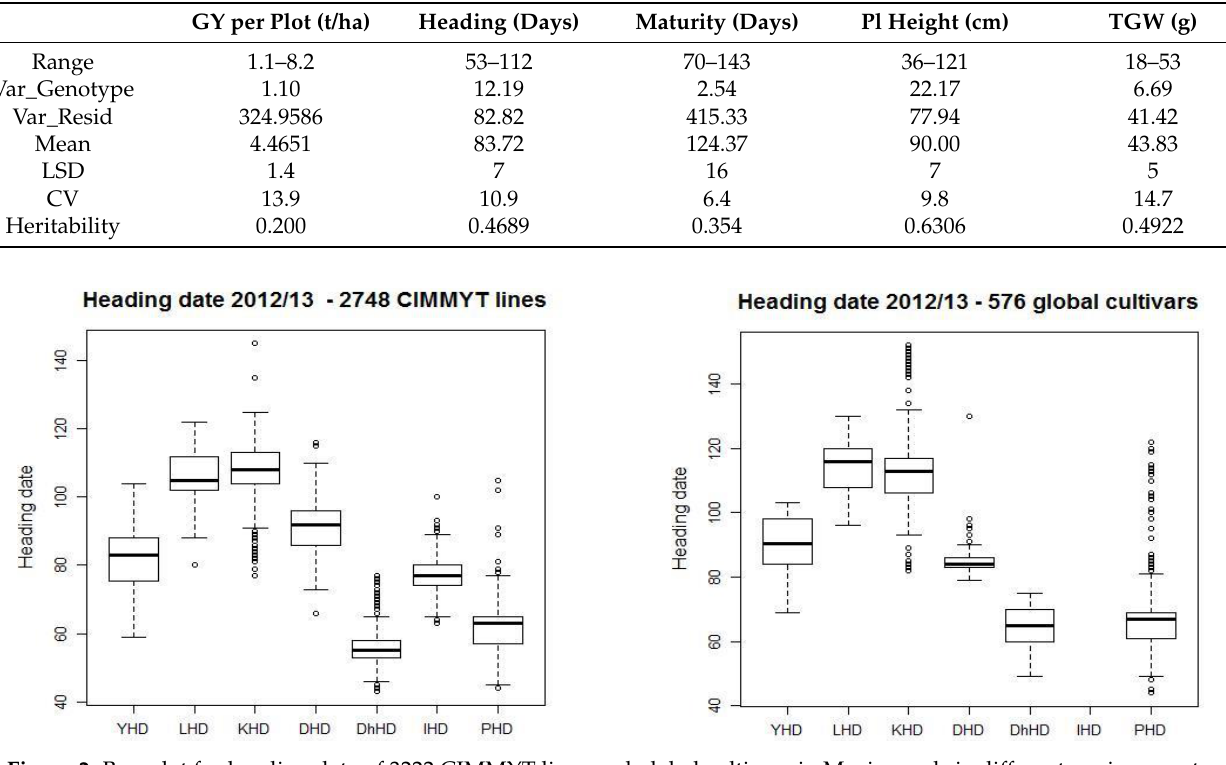
Figure 2. Box-plot for heading date of 3222 CIMMYT lines and global cultivars in Mexico and six different environments in India in 2012–2013. Y: Ciudad Obregon, L: Ludhiana, India, K: Karnal. D: Delhi, Dh: Dhawar. I: Indore, P: Pune. The standard error bars are shown as dotted lines and circles as outliers. The horizontal bar in the box is the median or 50 th